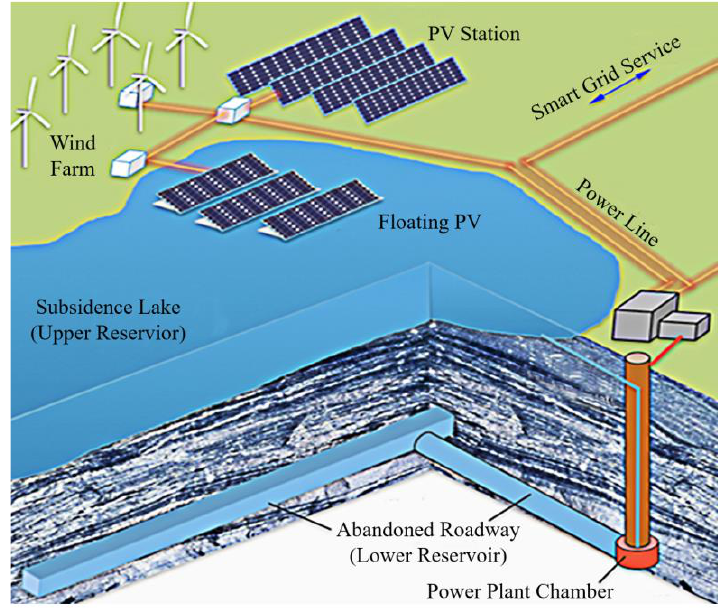
Figure 1. Surface subsidence area + underground roadway.